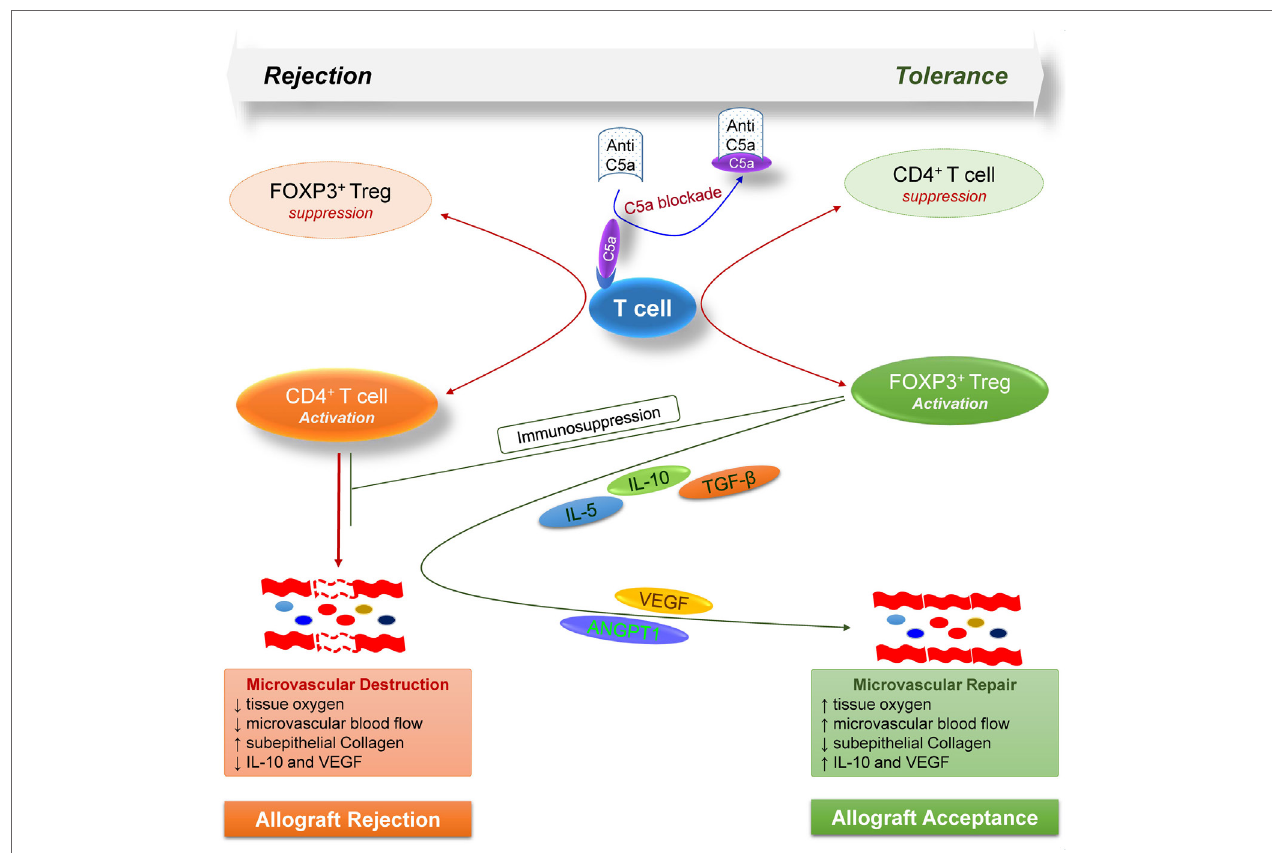
FigUre 7 | Model illustrates how, during allograft rejection, complement C5a blockade modulates the balance of regulatory and effector T cells, and repairs transplant associated microvascular flow through the release of various regulatory and angiogenic